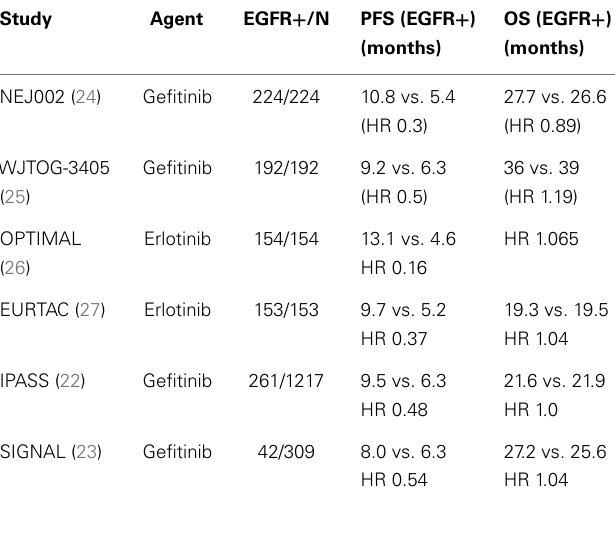
Table 1 | Randomized phase III trials of first-generation EGFR-TKIs in EGFR mutation ( + )/enriched populations